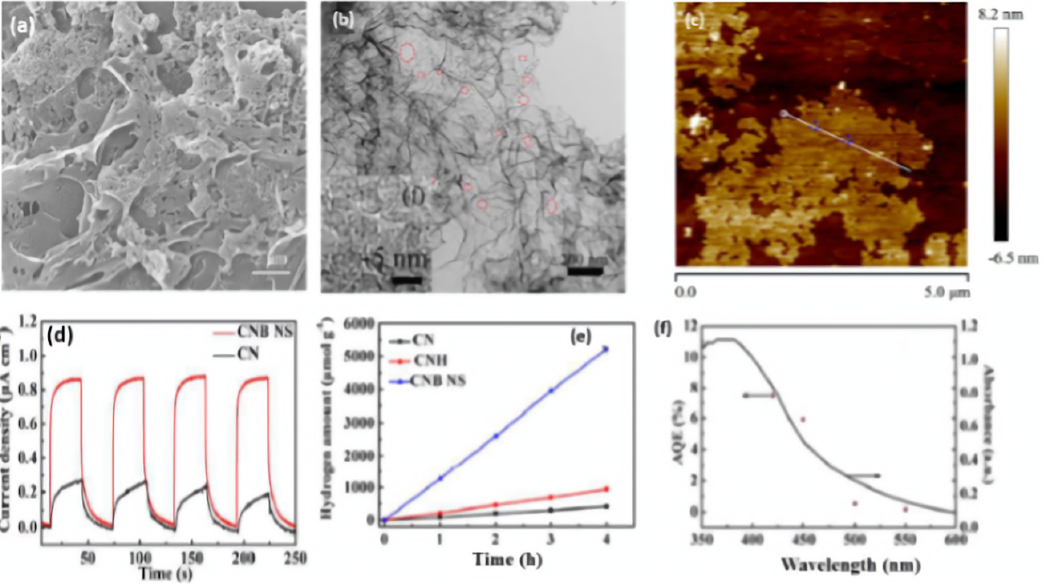
Figure 7. ( a ) SEM image, ( b ) TEM image, ( c ) AFM image of CNB NS. ( d ) Transient photocurrent–time curves, ( e ) H2 production amount on CNB NS, CNH, and CN nanocatalysts. ( f ) The wavelength-dependent AQE and absorption curve of CNBs. Reproduced with permission from Ref. [116]. 2018, Royal Society of Chemistry.